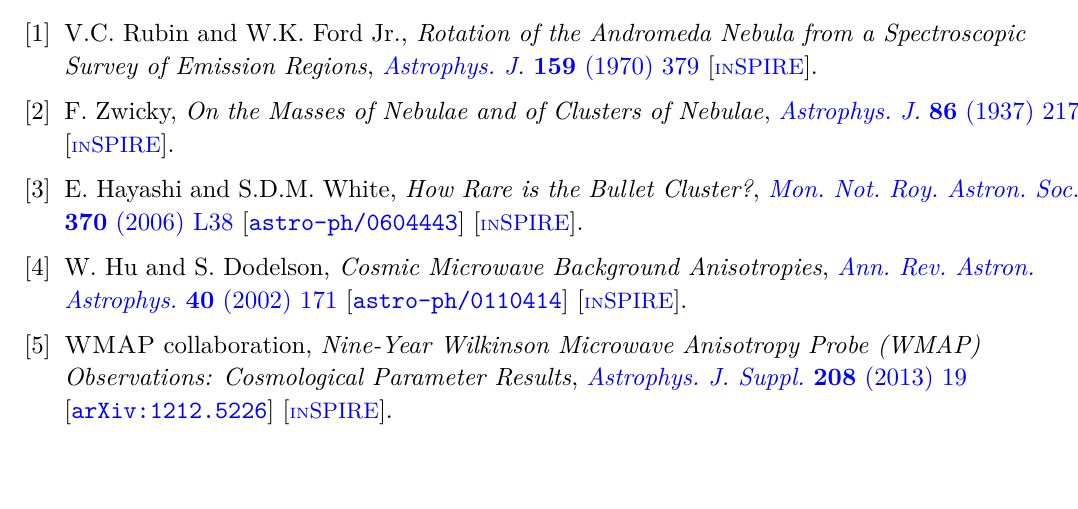
Figure 36. Condition C1-C4 for BP1 for various polarization configurations, P 1 0 ≡ { P +0 . 4 , P : − 0 . 6 } ; P 3 ≡ { P : +0 . 8 , P : − 0 . 3 } and P 3 0 ≡ { P e + e + e − R C 1 as a function of L for different n values (sky blue shaded region marks R C 1 ≥ 2 ); (b) Same as (a) but for R ; (c) R as function of ∆ t and (d) Same as (a), but for R C 2 C 3 Open